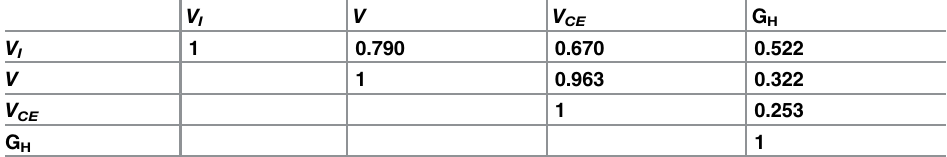
Table 5. Spearman correlation coefficients between every pair of significant variables in our study. Boldfaced numbers indicate significant correlations (p < 0.05).